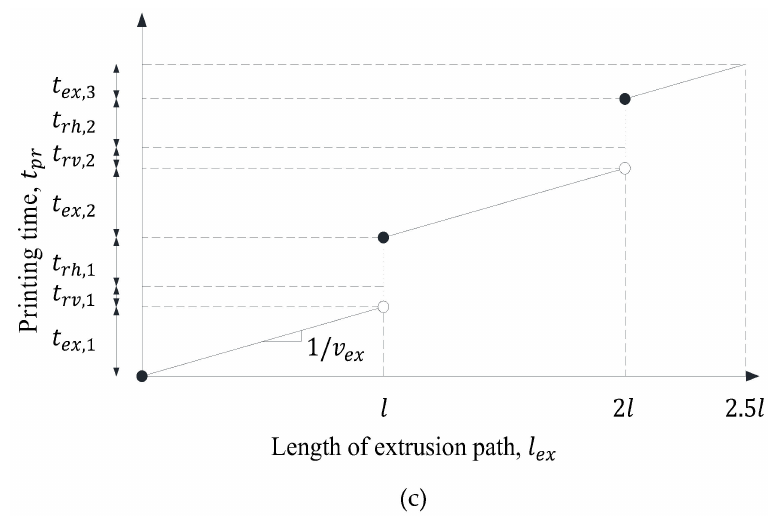
Figure 5. Classification of printing path ( l pr ) & l ex − t pr curve. ( a ) Vertically layered fresh concrete; ( b ) Classification of printing path ( l pr ); ( c ) l ex − t pr